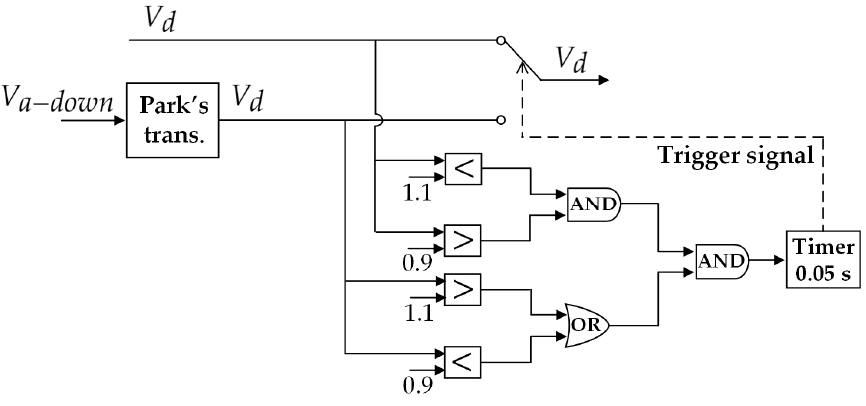
Figure 4. Control diagram of the voltage selector.